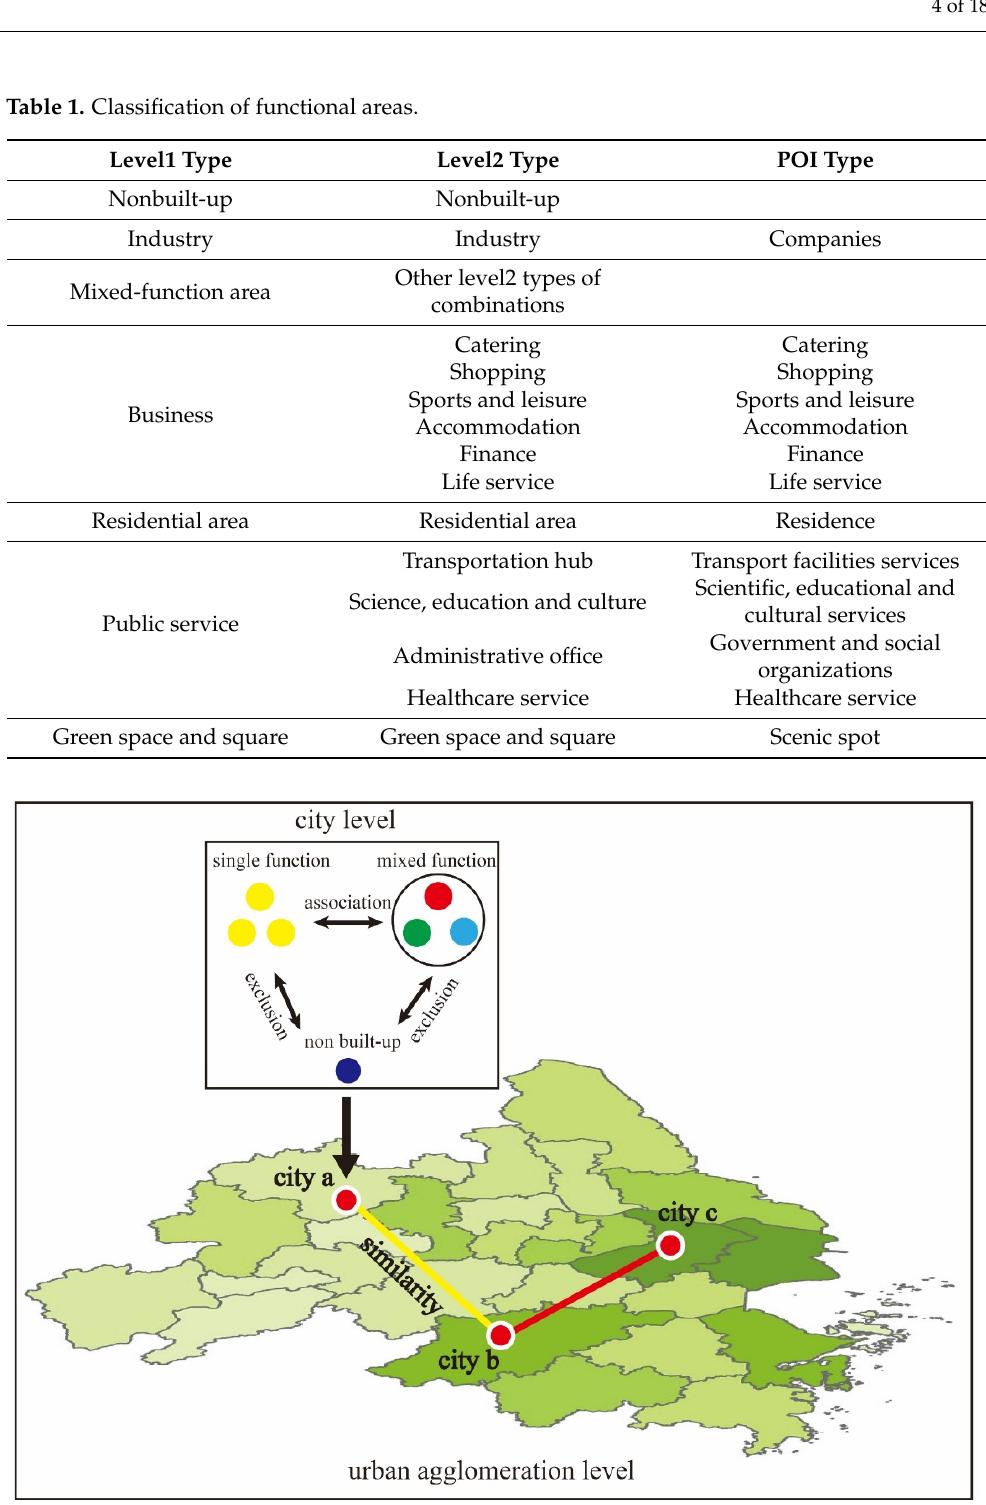
Figure 1. Two analytical levels for mining spatial correlation pattern.